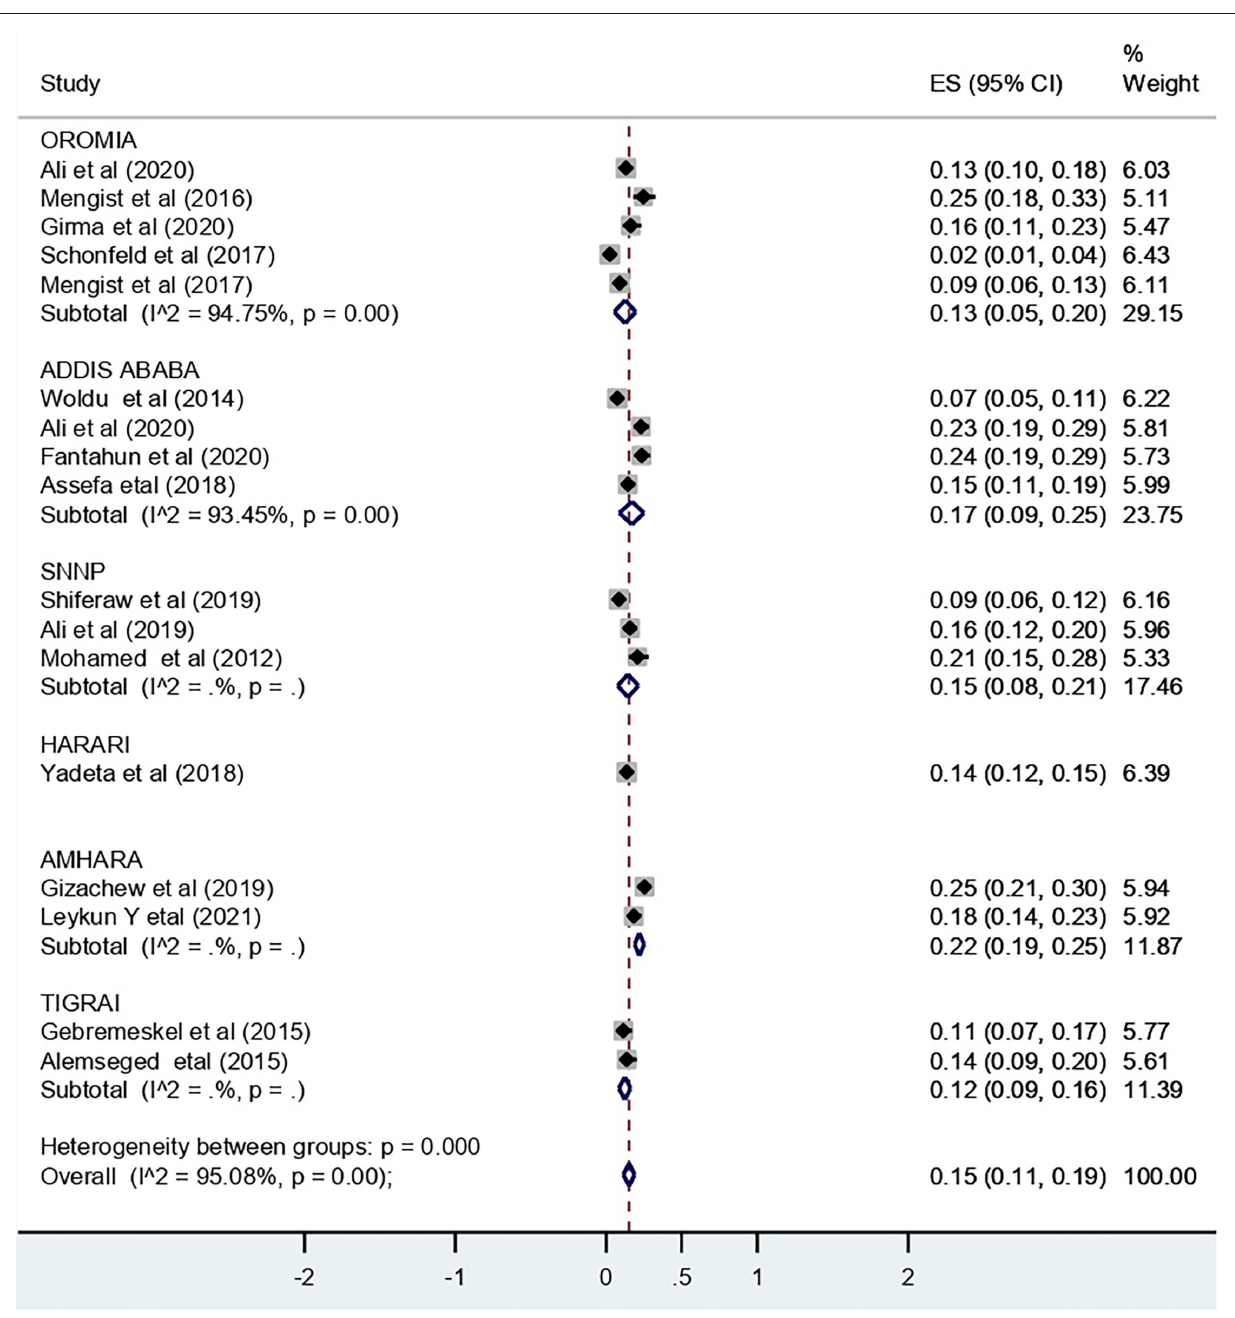
overall estimates of maternal recto-vaginal GBS colonization proportion from 11 studies with 2,205 pregnant women